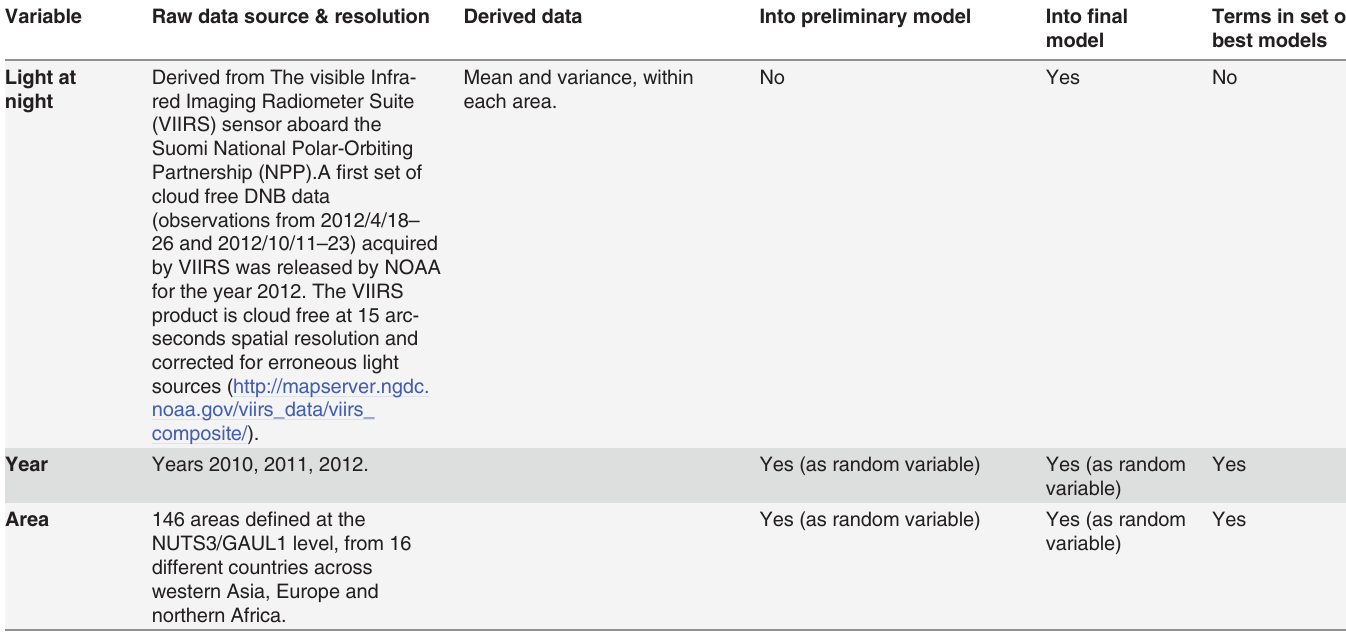
Landscape. For each land use class (GlobCover and Anthromes), protected areas, and water bodies, percentage cover was calculated within each NUTS3/GAUL1 area. Pielou ’ s